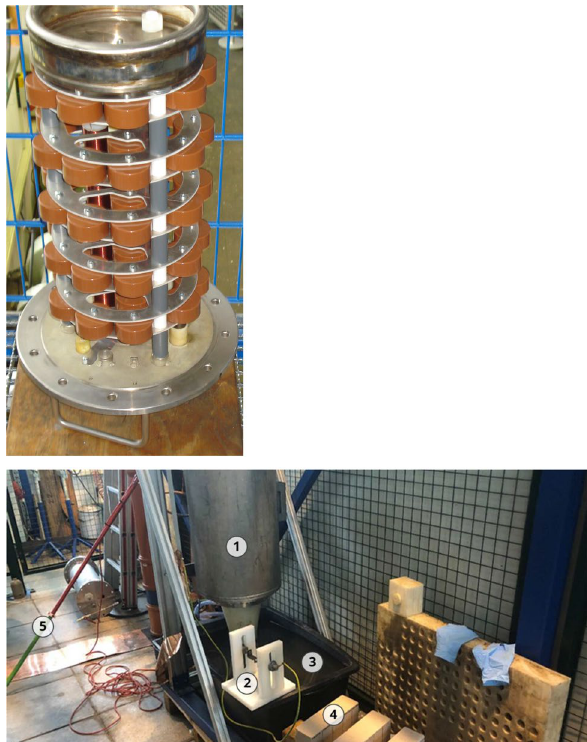
Fig. 5 Five stage impulse voltage generator and test stand for the investigation of the EIT for concrete removal ((1) impulse voltage generator, (2) electrode arrangement, (3) water basin, (4) test speci- men, (5) earthing unit)